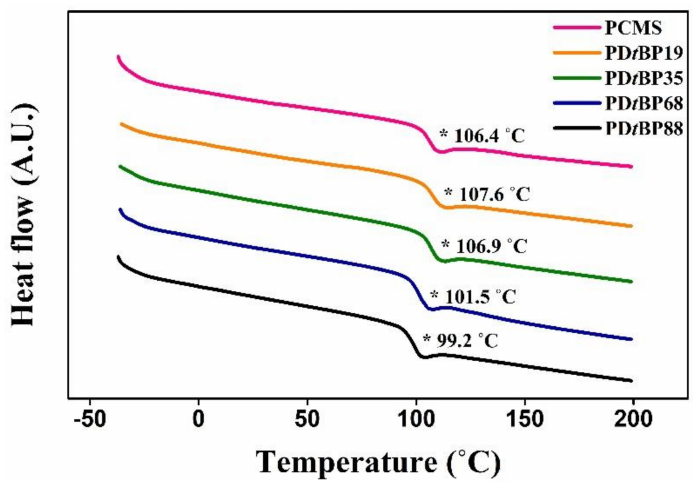
Figure 4. Differential scanning calorimetry (DSC) thermogram of 2,4-di- tert -butylphenoxymethyl modified polystyrene (PD t BP#). (* means the status of glass